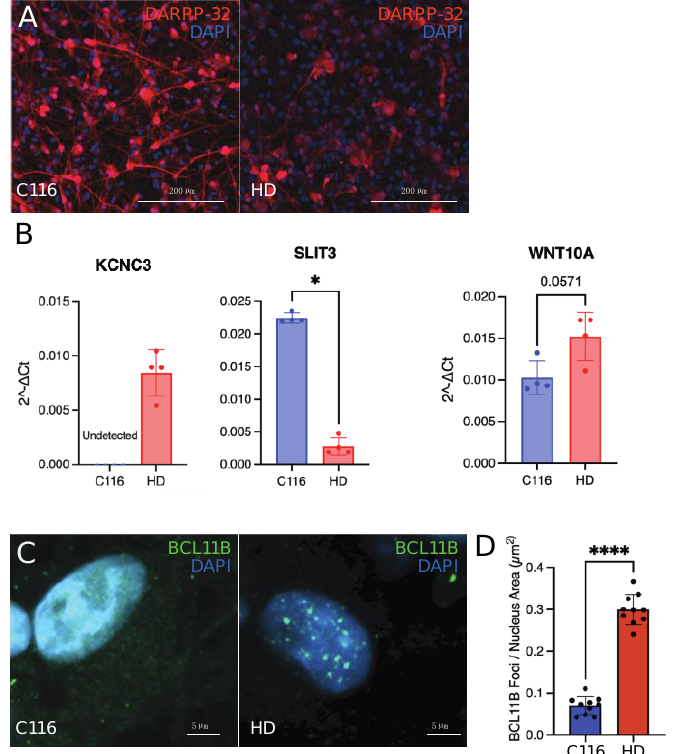
Figure 7. Human MSNs derived from HD patient iPSCs reveals mislocalization of BCL11B into nuclear aggregates. ( A ). Isogenic HD72 and C116 MSNs differentiated from iPSCs immunostained with DARPP-32. ( B ). Top genes dysregulated in D9-Cre-Bcl11b tm1.1Leid mice follow similar trends in expression as measured by RT-PCR. KCNC3 and WNT10A are upregulated in HD72-MSNs, compared to control C116. Like the D9-Cre-Bcl11b tm1.1Leid mice transcriptomics, SLIT3 was downregulated in HD-MSNs. ( C ). IHC with BCL11B antibody show more large nuclear aggregates in the HD72-MSNs than in C116-MSNs. ( D ). Quantification of the BCL11B foci per nuclear area in isogenic HD72 and C116-MSNs. * p < 0.05; **** p < 0.0001, Mann Whitney